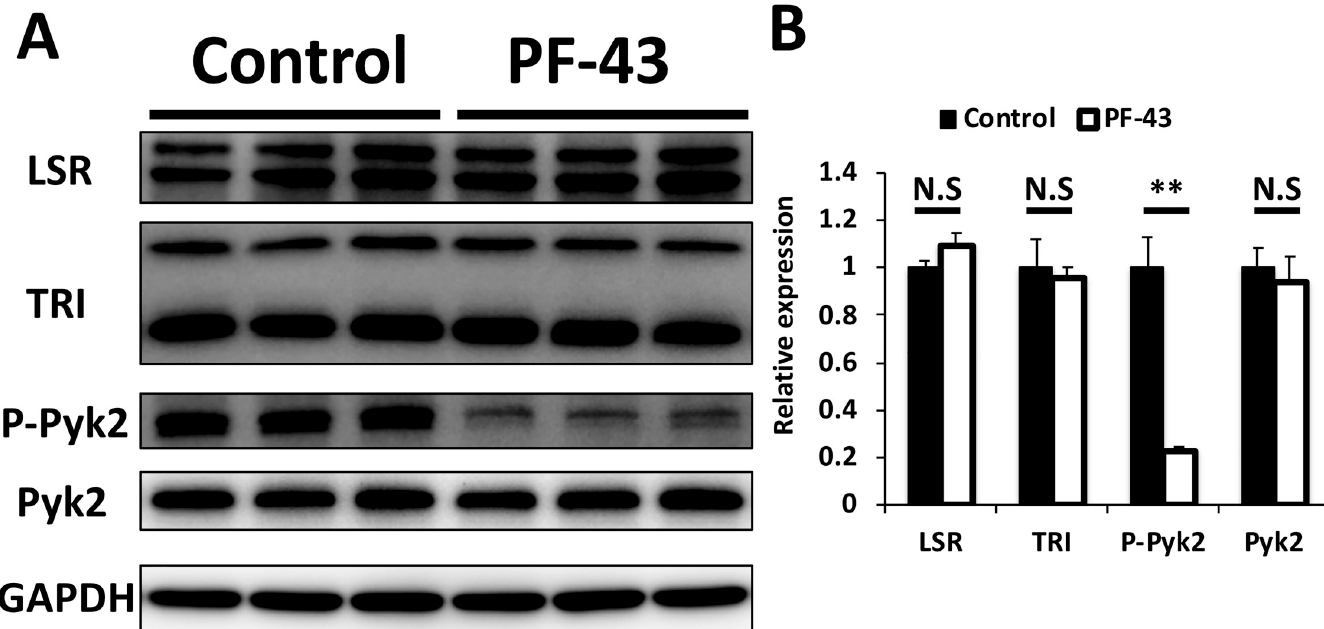
Fig 3. Expression of tTJ proteins in PF-43-treated EpH4-Cl3 cells. (A) EpH4-Cl3 cells were incubated with DMSO (Control) or 20 μ M PF-43 for 120 min, and the extracts were subjected to immunoblotting using antibodies against LSR, tricellulin (TRI), phosphorylated Pyk2 (Tyr402) (P-Pyk2), Pyk2, and GAPDH. (B) Band intensities of LSR, TRI, P-Pyk2, and Pyk2 in (A) were measured and normalized to GAPDH expression. The expression level of each protein in control cells was set to 1. The means and SEMs are shown in the graph ( n = 3; �� p < 0.01; N.S. p > 0.05).